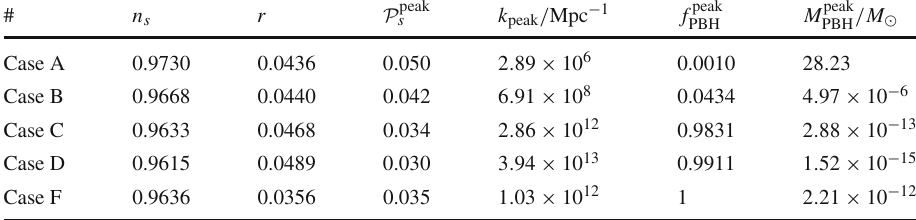
Table 1 The elected parameter assortments for Cases A, B, C, D, and F. The value of λ is fixed by the power spectrum restriction (24) at horizon crossing e -fold number N ∗